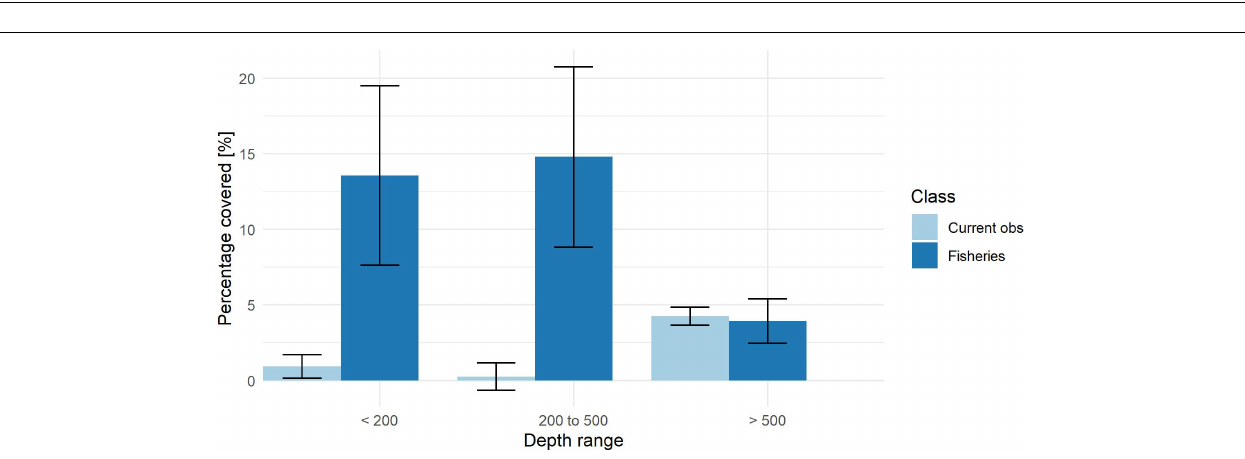
FIGURE 5 | (A) Mean monthly number of sub-surface observations for the Alaska region. (B) Mean monthly number of fishing events for judged suitable for potential data collection. (C) Distribution of both fishing events and ocean observations, with overlap between the two plotted in purple. Note: waters north of 60 ◦ are often covered by sea ice, making difficult both fishing and ocean observation.